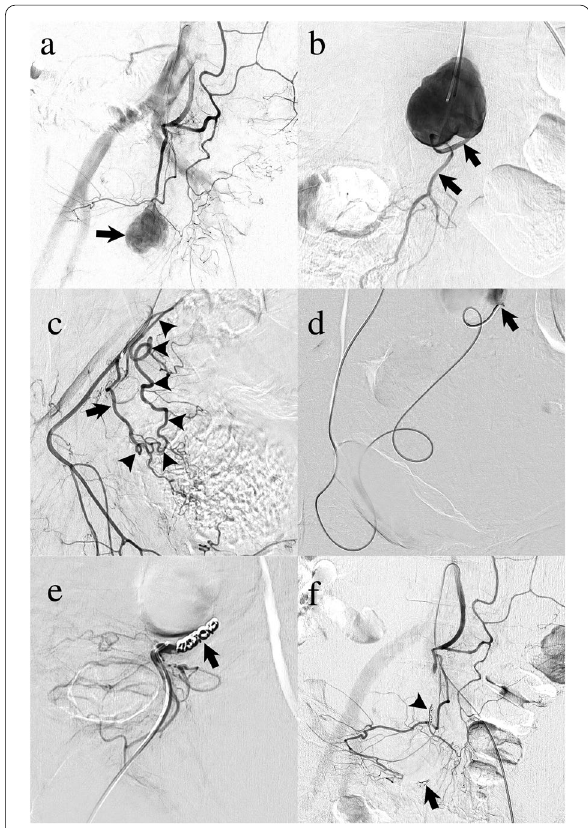
Fig. 2 a Inferior mesenteric arteriogram showing the superior rectal artery (SRA) trunk aneurysm (arrow). b Aneurysmogram showing the distal SRA trunk (arrows). c Internal pudendal arteriogram showing the middle rectal artery (MRA) (arrow) and MRA-SRA anastomosis (arrowheads). d A high-flow type microcatheter is advanced into the SRA trunk distal to the aneurysm (arrow) via MRA-SRA anastomosis using the coaxial microcatheter system. e Retrograde arteriogram after coil embolization (arrow) showing complete occlusion of distal SRA. f The final inferior mesenteric arteriogram after proximal coil embolization showing complete cessation of blood flow into the aneurysm. Note that the coils are deployed distally (arrow) and proximally to the aneurysm